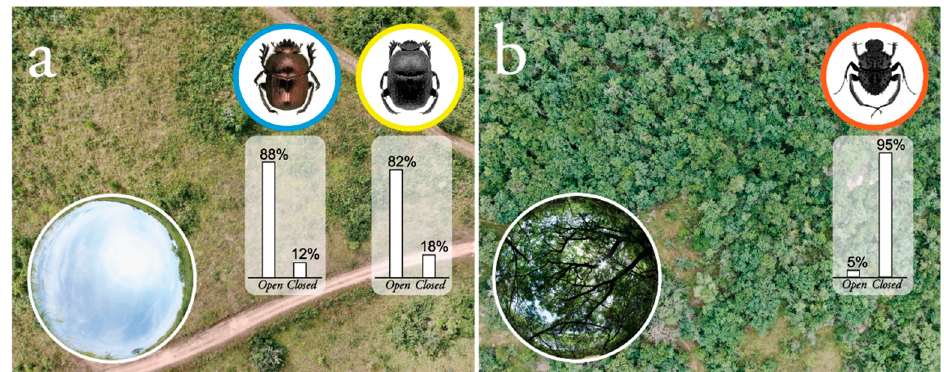
Figure 1. Dung beetles from three tribes of ball-rollers and the bioregions they inhabit. Beetles from three tribes of ball-rollers ( blue-bordered image : Scarabaeini; yellow-bordered image : Gymnopleurini; red-bordered image : Sisyphini) were collected within the same savanna biome. K. nigroaeneus and G. unicolor were predominantly found actively foraging in the open habitat ( a ) and S. fasciculatus predominantly foraged within the closed habitat ( b ) of the same bioregion. A histogram, illustrating the percentage of individuals found in the open and closed habitat over three consecutive sampling days, is presented below each respective beetle image. A 180° view of the sky from the ground perspective of the beetle is included at the bottom of each panel.